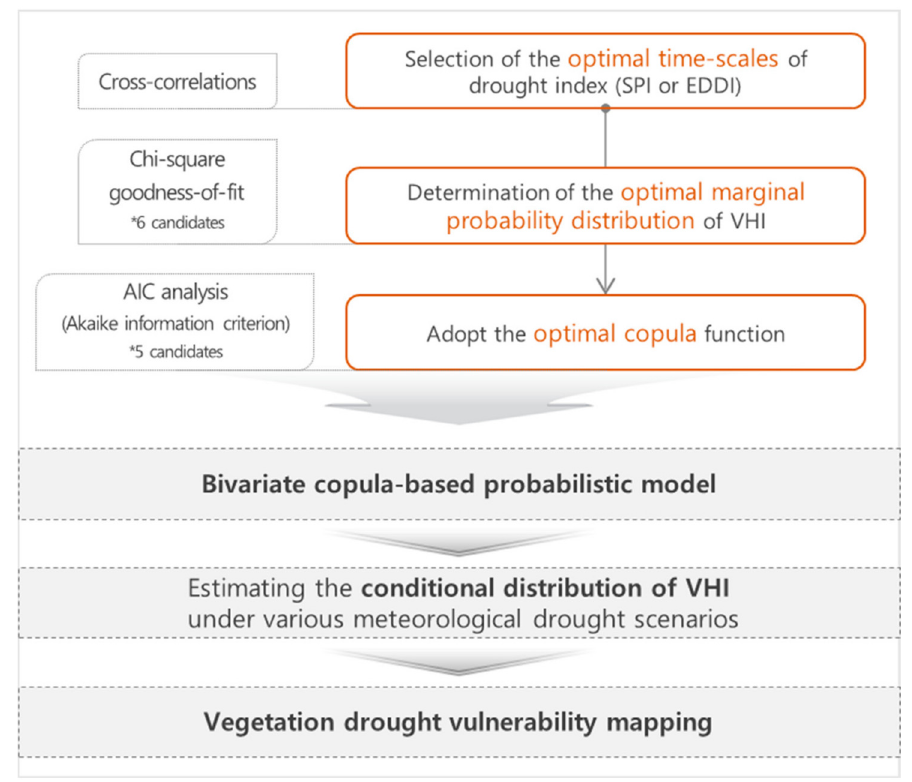
Figure 2. Study procedure